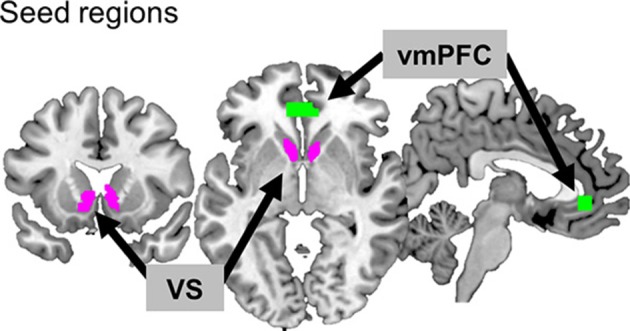
Two seed regions. The ventromedial prefrontal cortex (vmPFC) and ventral striatum (VS) are depicted in green and purple, respectively.